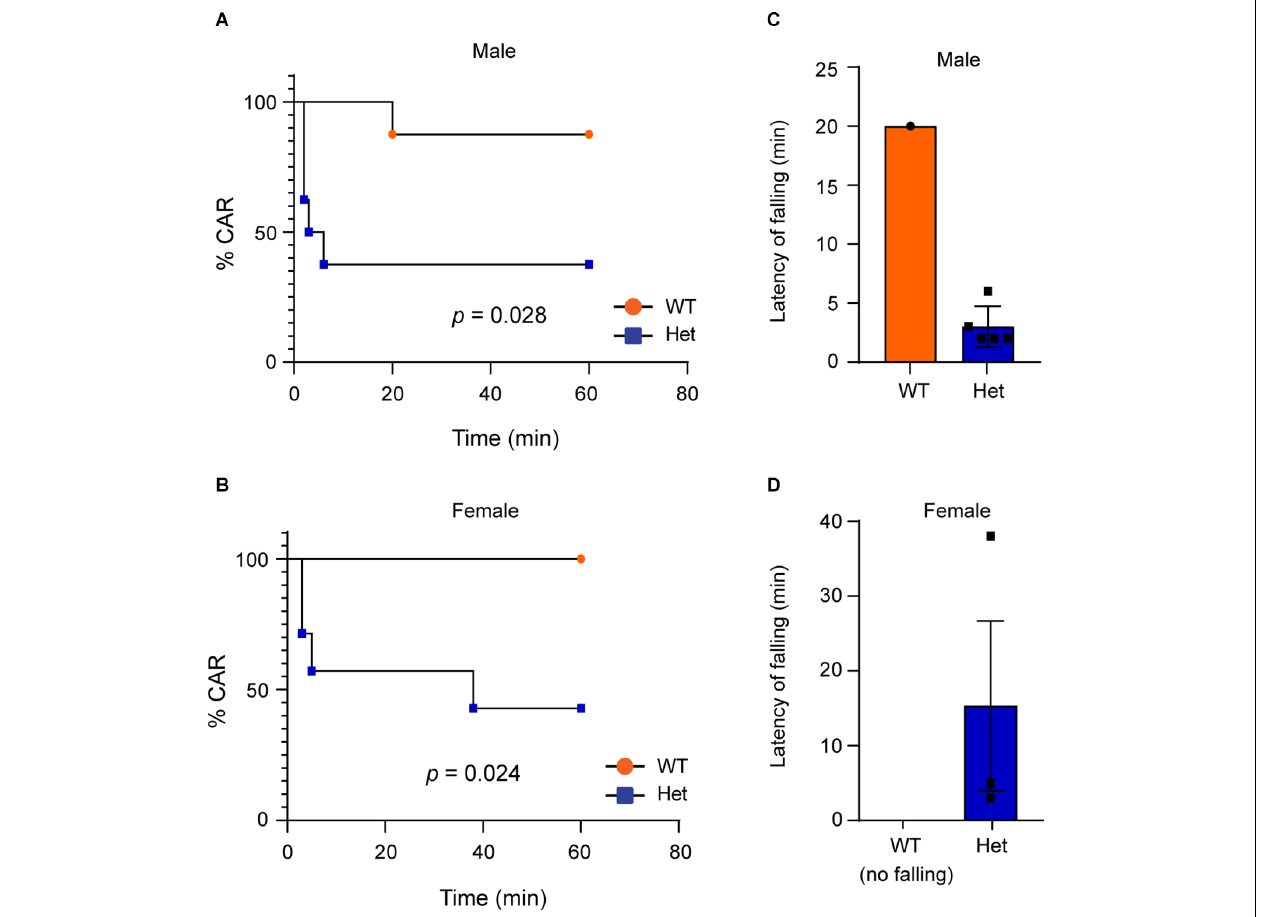
FIGURE 5 | Heterozygous Kdm6b knockout mice display impulsive-like behaviors. (A,B) Graphs represent the time course of CAR measurement in wild-type and heterozygous Kdm6b -cKO male (A) and female (B) mice in a 60-min CAR testing period. n = 8 males and 7 females per genotype. P-values calculated using a Log-rank (Mantel-Cox) test. male: p = 0.028; female: p = 0.024. (C,D) The bars showing the latency of male (C) and female (D) wild-type and heterozygous Kdm6b -KO mice to fall from the